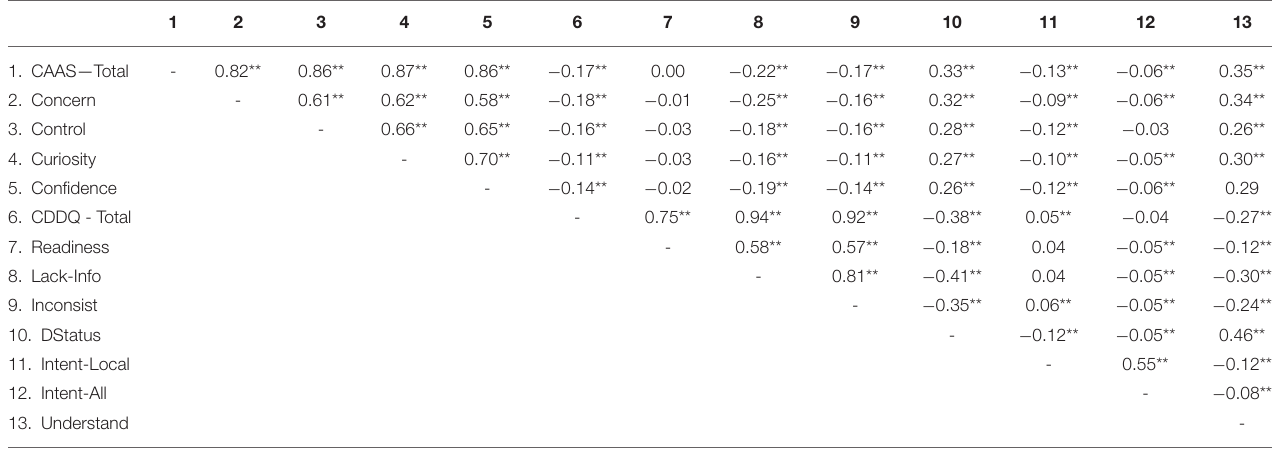
TABLE 4 | Intercorrelations among